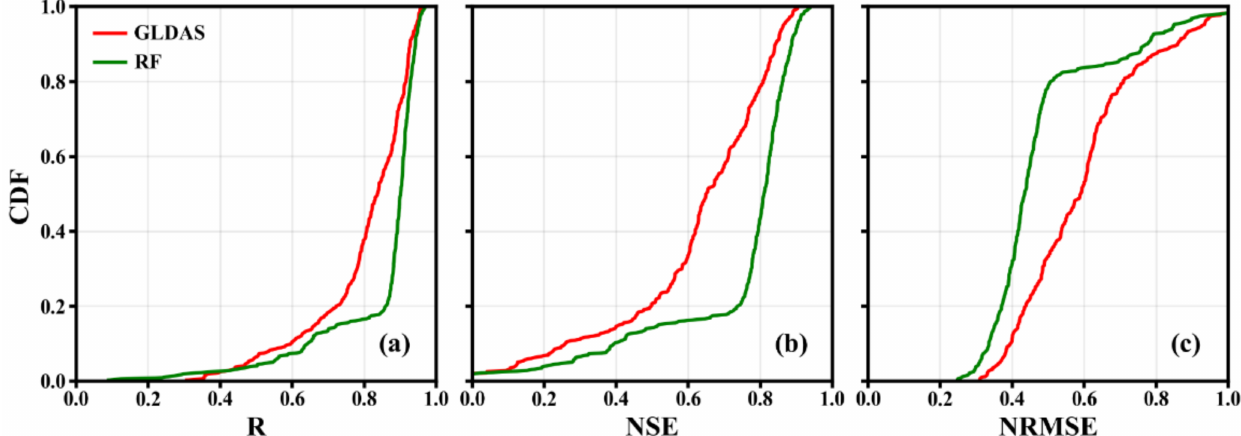
Figure 6. ( a – c ) represent the Cumulative distribution functions (CDFs) of the R, NSE, and NRMSE values derived from the Figure 5. Red indicates the GLDAS model, and green indicates the RF model.